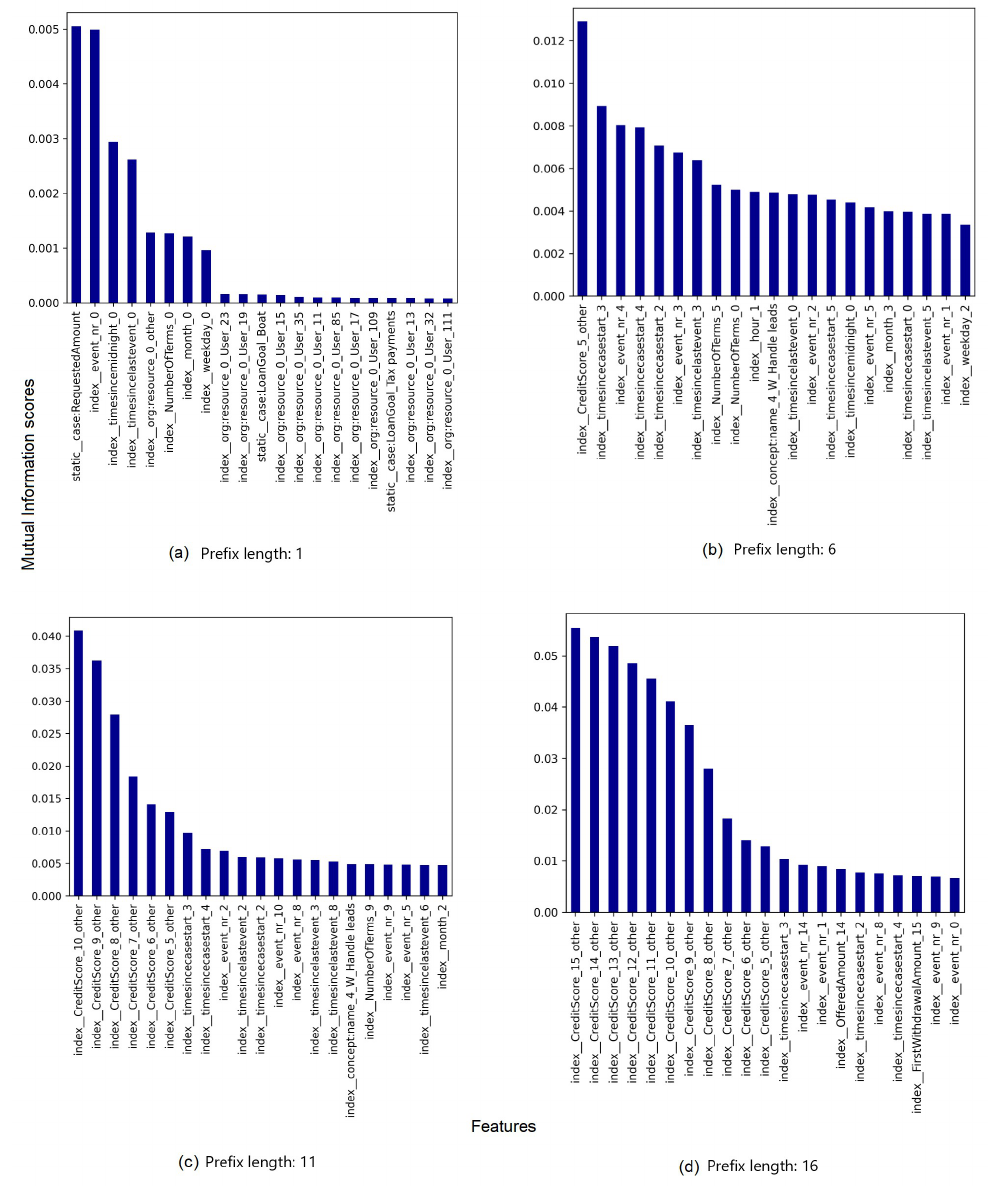
Figure 5. Mututal Information analysis of BPIC2017_Refused preprocessed with prefix index-